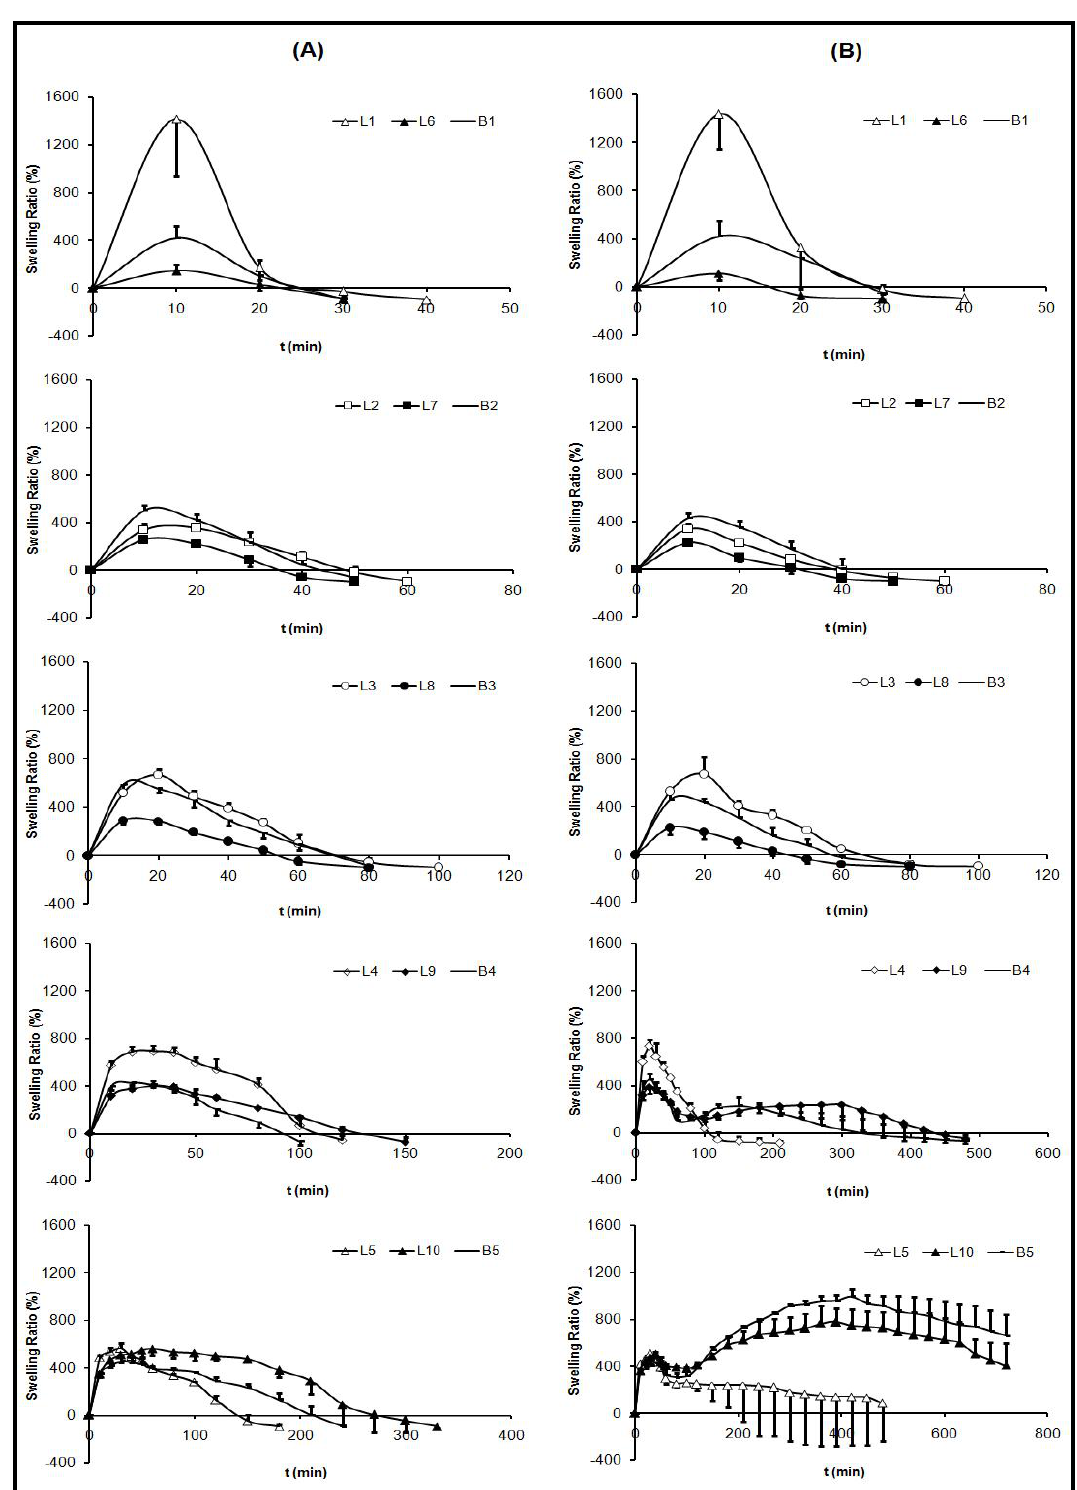
Figure 2. Swelling ratio of freeze-dried systems B1 (1% CS), B2 (2% CS), B3 (3%